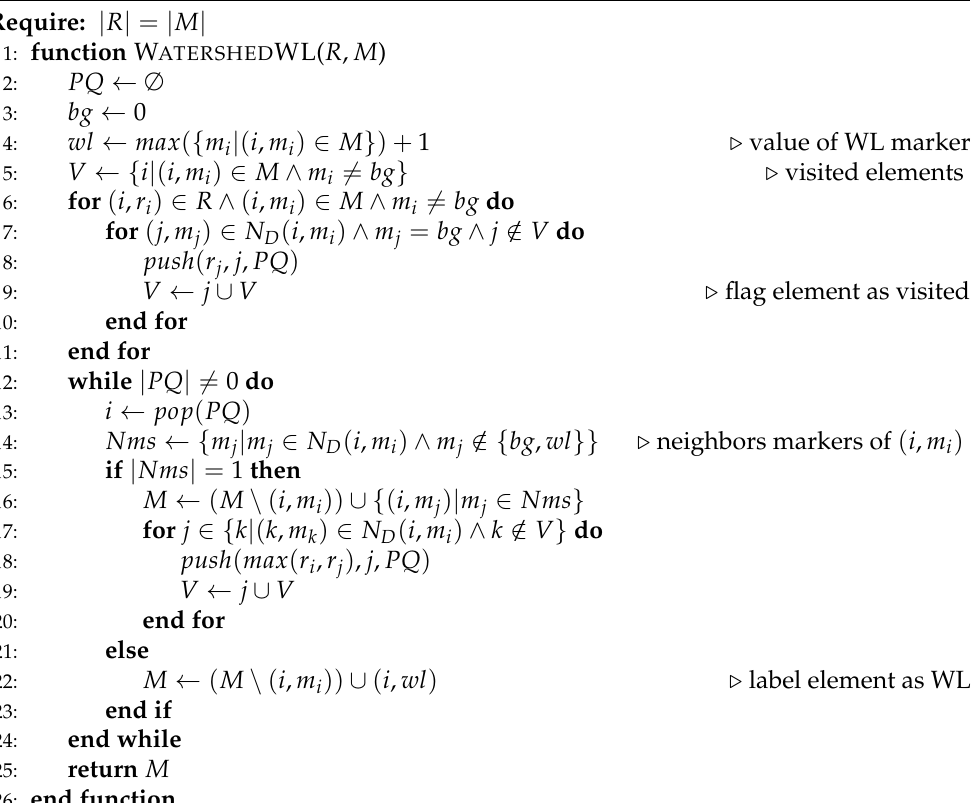
Algorithm 2 The marker-controlled watershed with WL construction by Meyer